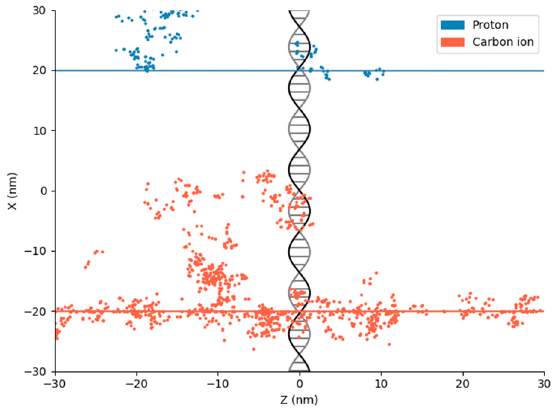
Figure 3. Illustration of track structure and energy deposition distributions for a 10 MeV proton (~5 keV/ µ m LET, blue, top) and 200 MeV carbon ion (~100 keV/ µ m LET, red, bottom), together with a schematic representation of DNA for scale. For both particles, the primary particle track (lines) deposits only a small fraction of the total energy, with large amounts of energy being deposited in the vicinity of the track core by low energy secondary electrons, with individual energy depositions here shown as points. It can be seen that while the proton deposits energy relatively sparsely, the carbon ion deposits energy extremely densely along its track, potentially causing multiple closely spaced damages within any DNA it traverses.